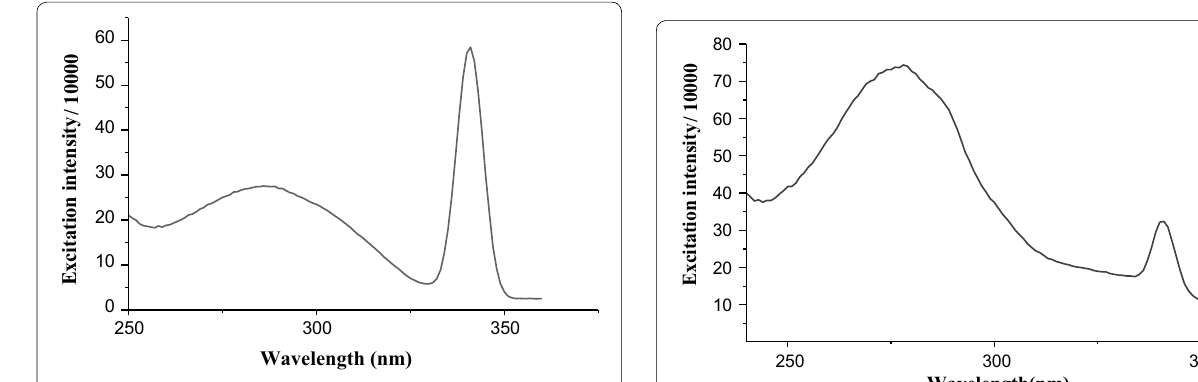
Fig. 6 Fluorescence excitation spectrum of standard caffeine in water